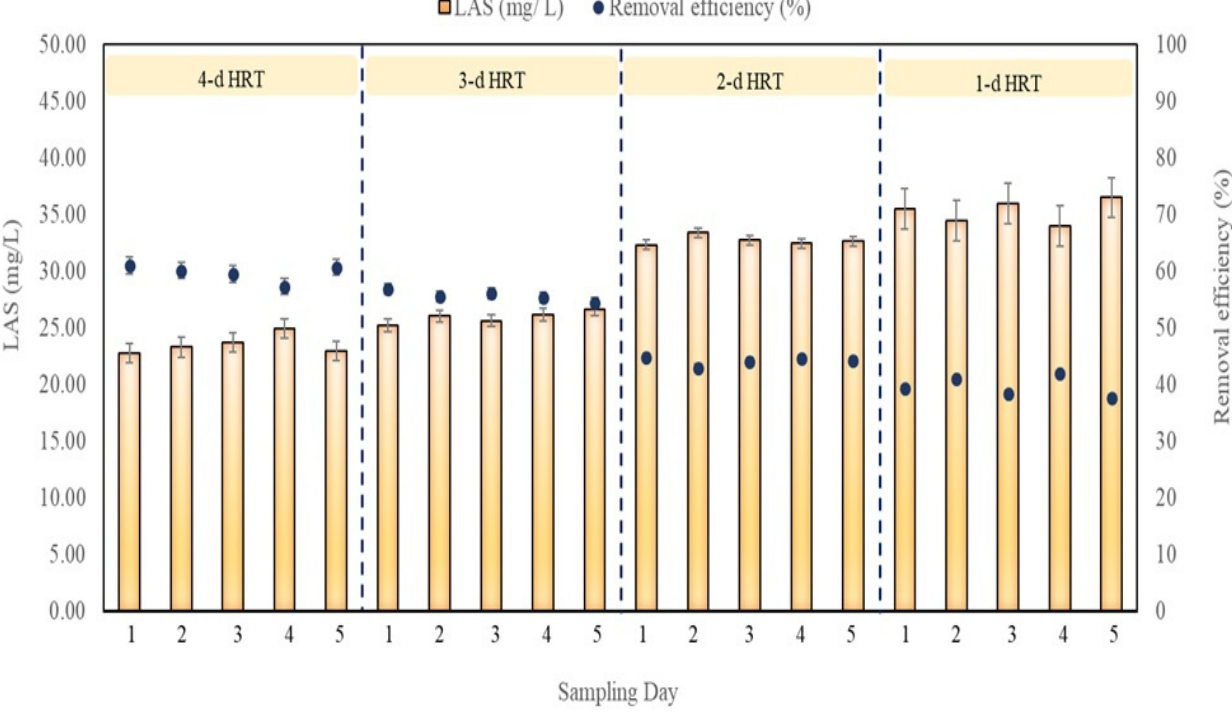
Figure 3. Concentrations and removal efficiencies of anionic surfactants in MEC at different HRTs.